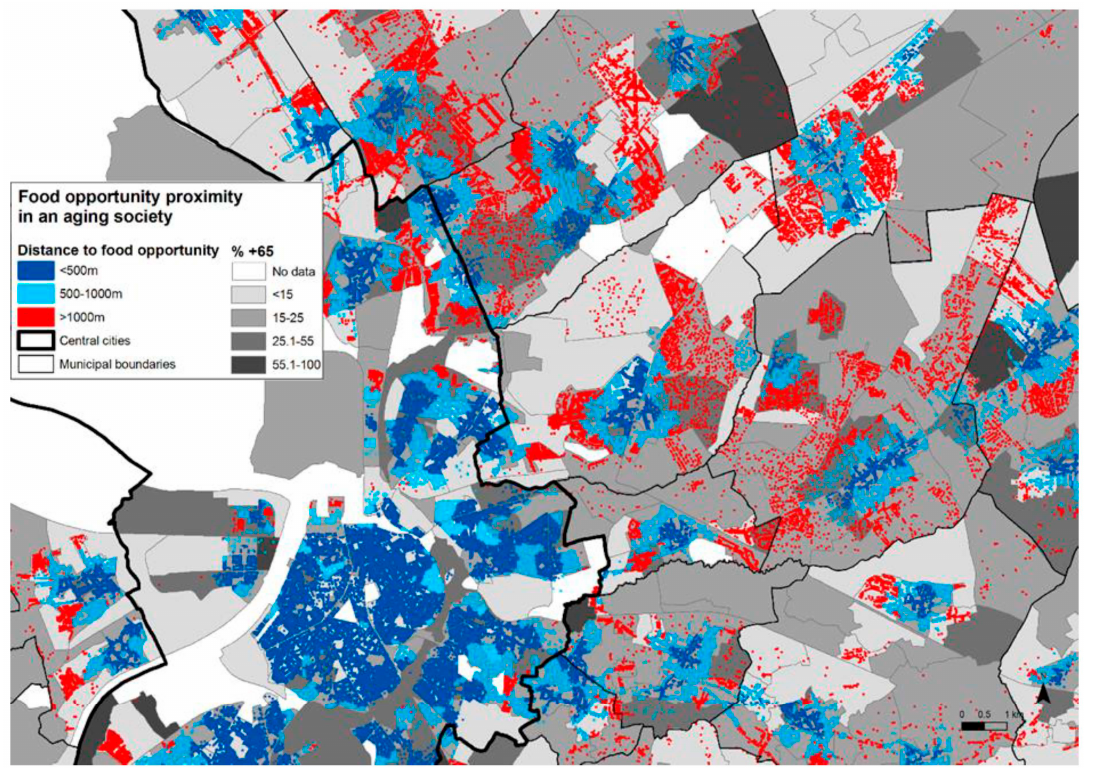
Figure 2. Walking distances to food opportunities and % residents + 65 in Antwerp and its north- eastern suburbs. Reprinted with the permission of [36]. Jeroen Cant, 2022